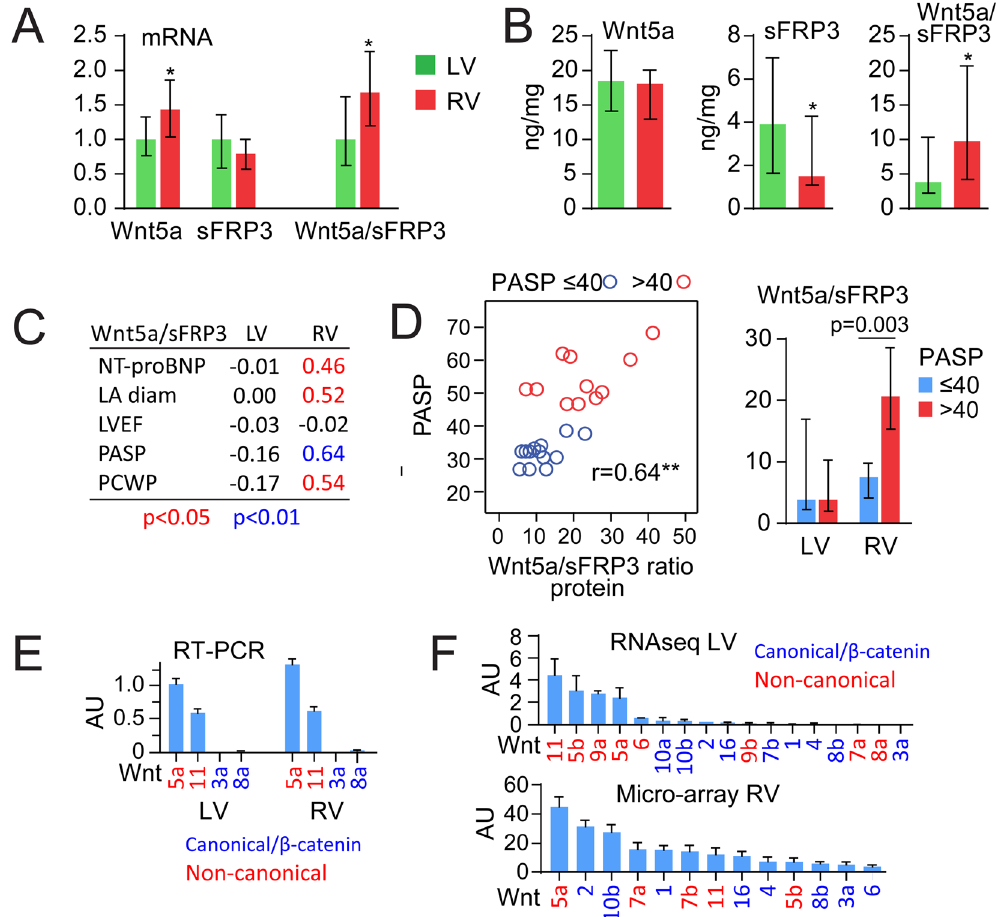
Figure 3. Wnt5a and sFRP3 expression in the myocardium of DCM patients. ( A ) mRNA and ( B ) protein levels of Wnt5a, sFRP3 and their ratio (Wnt5a/sFRP3) in the LV and RV myocardial tissue of DCM patients (n = 25). ( C ) Correlations between Wnt5a/sFRP3 ratio and NT-proBNP (n = 25), LA diameter (n = 20), LVEF (n = 23), PASP (n = 24) and PCWP (n = 24) in the LV and RV of DCM patients. ( D ) Correlation between Wnt5a/sFRP3 ratio and PASP in the RV and comparison of the Wnt5a/sFRP3 ratio within the LV and RV between DCM patients with pulmonary hypertension (i.e. PASP > 40 mm Hg, n = 11) and without it (i.e. PASP ≤ 40 mm Hg, n = 13). ( E ) mRNA expression of typical canonical and non-canonical Wnt ligands in the LV and RV of DCM patients obtained in preliminary studies. ( F ) mRNA expression profiles of other Wnt ligands in the RV of DCM patients (GSE29819) as well as some RNAseq data from the LV (GSE71613) obtained from the GEO repository. DCM, dilated cardiomyopathy; LA, left atrial; LV, left ventricle, LVEF, left ventricular ejection fraction; NT- proBNP, N-terminal pro-brain natriuretic peptide; PASP, pulmonary artery systolic pressure; PCWP, pulmonary capillary wedge pressure; RV, right ventricle; sFRP3, secreted frizzled-related protein